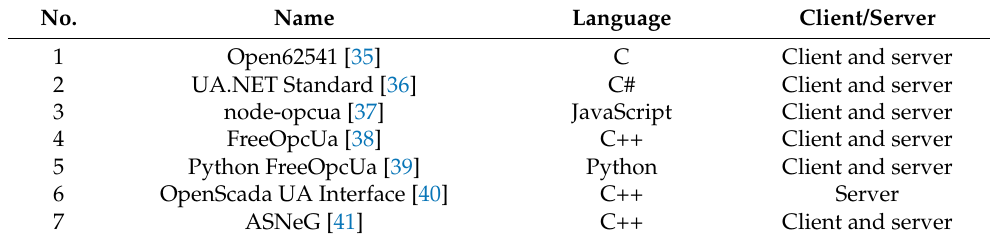
Table 10. OPC UA open-source implementation list.